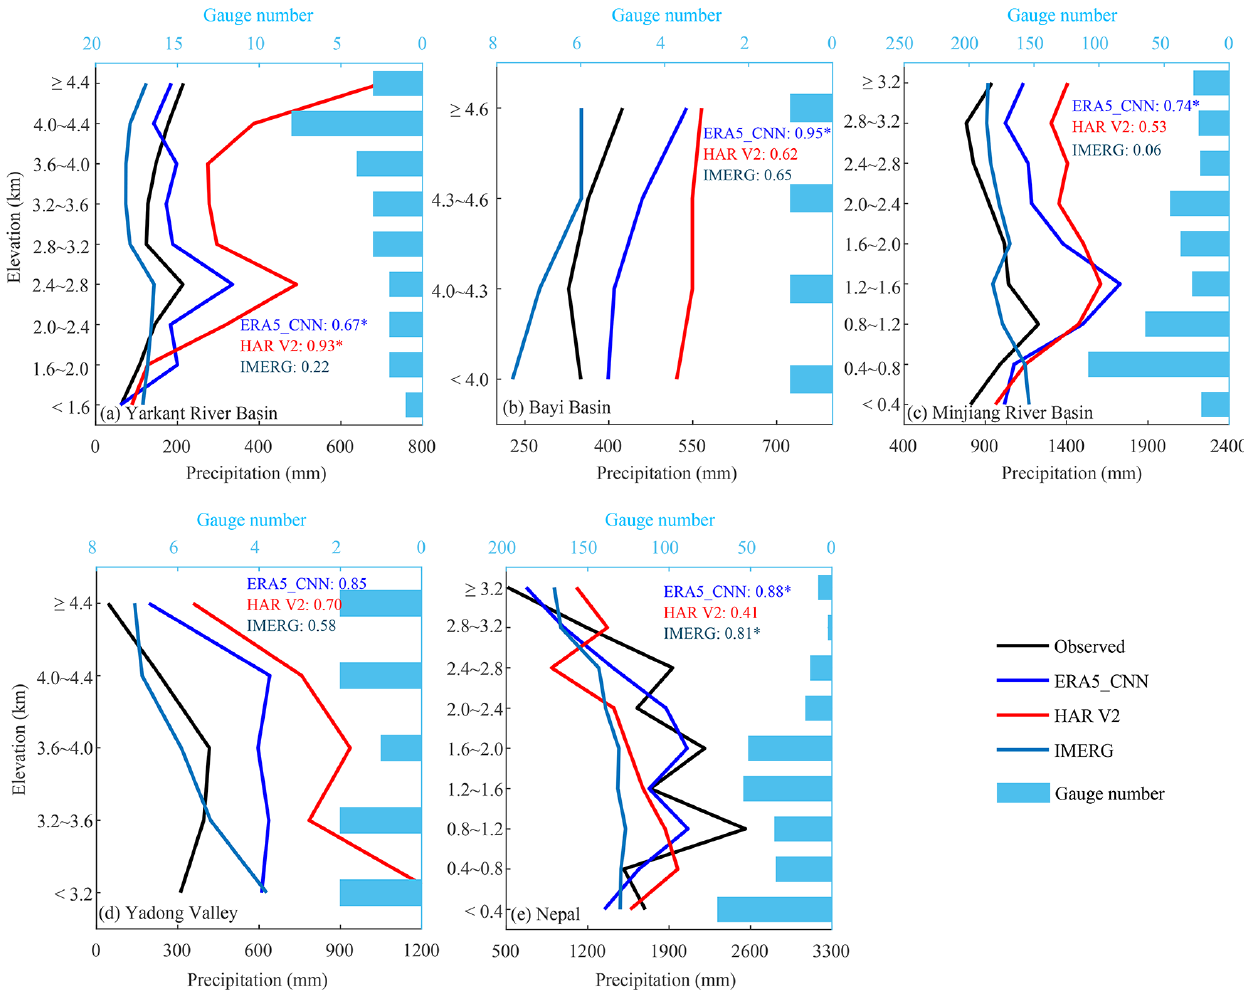
Figure 2. Comparison between the altitude dependence of precipitation from ERA5_CNN, IMERG and HAR V2 and that from rain gauge data in five networks. The lines show the average precipitation amount in each altitude zone and the bars denote the number of rain gauges in each zone. The numbers in the figures give the spatial correlations of the precipitation amount between the rain gauge data and precipitation products. The “ ∗ ” represents the correlation that is significant at the 95% confidence